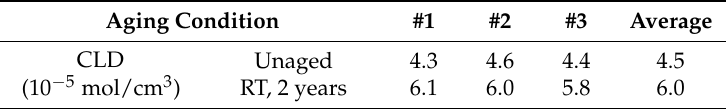
Table 5. Crosslink density for room temperature–aged specimens.